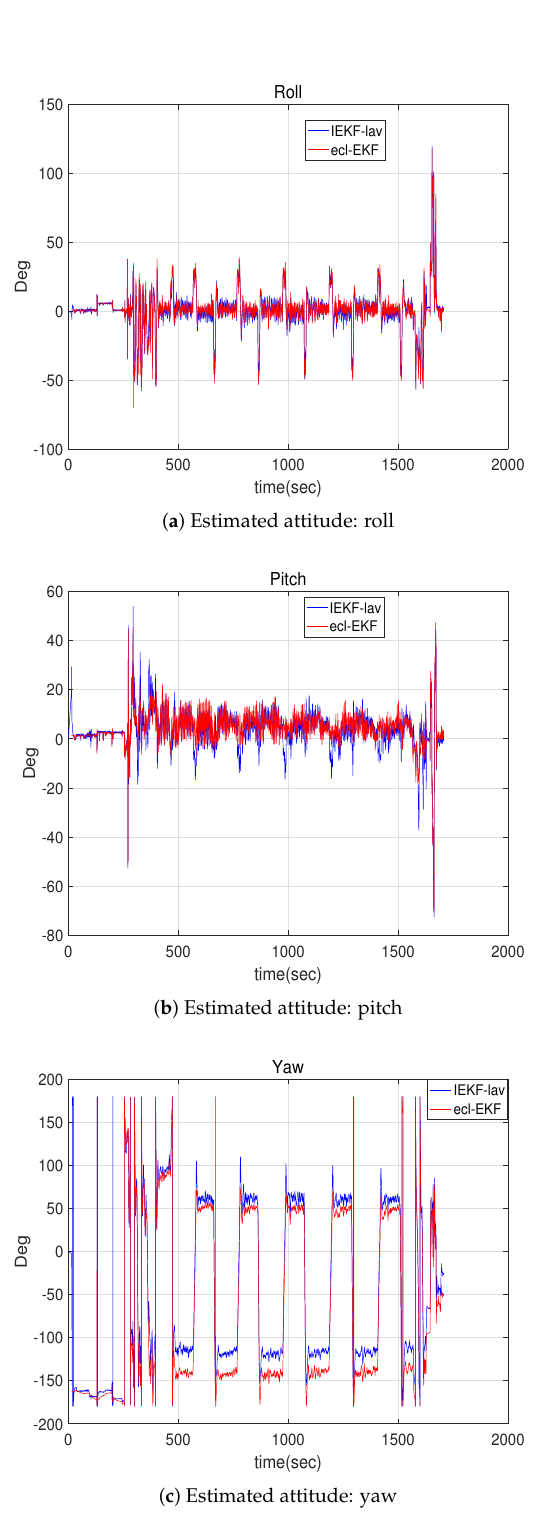
Figure 5. Attitude represented by Euler angles estimated by IEKF-lav and